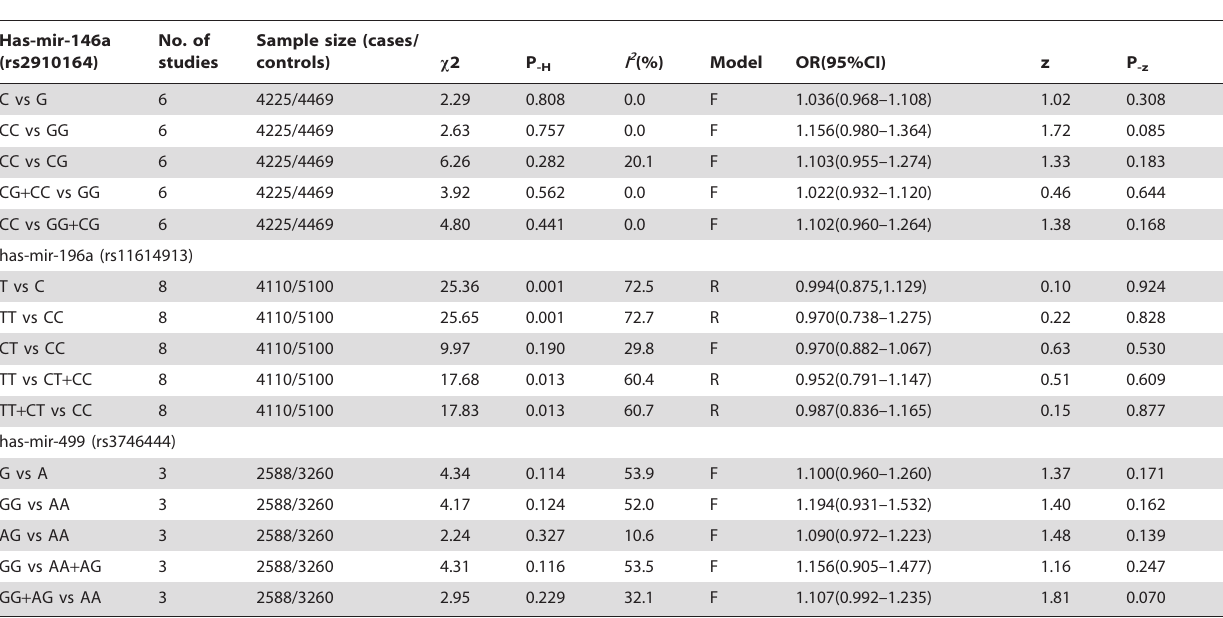
Table 2. Meta-analysis results for the four polymorphisms and breast cancer risk. (OR, odds ratio; CI, confidence interval.)